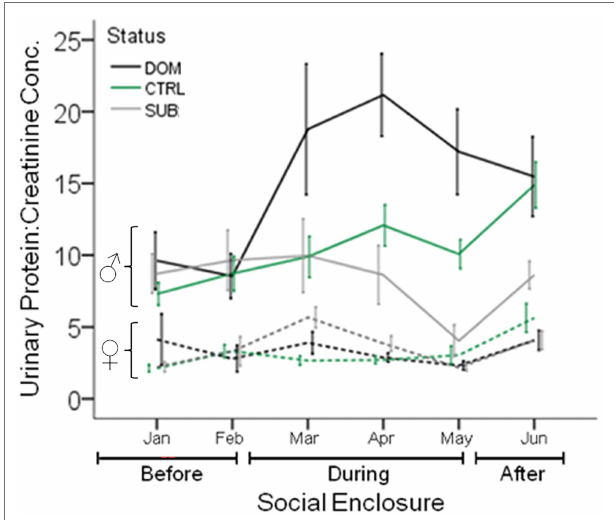
FIGURE 5 | Urinary Protein Excretion in Seminatural Contexts. The urinary protein excretion of wild-derived male and female house mice over time, before, during, and after their release into seminatural conditions. Lines show the mean protein excretion of males (solid lines) and females (dashed lines) caged singly in the laboratory (Before), and also while they were living in large enclosures for 12wk (During), and for 4 weeks after capture and being returned to single-caged housing (After). Dominant (DOM) versus subordinate (SUB) status is indicated by black and gray lines, respectively. Control mice (CTRL) are indicated by the green line. Error bars display ±1 SEM. Data from Thoß et al.